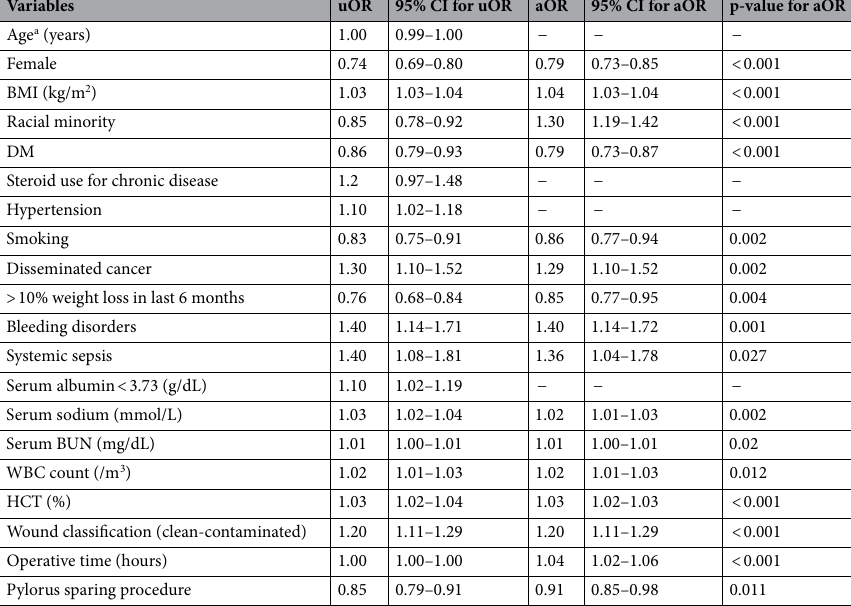
Table 4. Bivariate regression and multivariate regression analysis results for the risk factors of organ-space SSIs. Variables dropped from the model due to insignificance at the multivariate level: preoperative serum albumin, steroid use for chronic condition, age and hypertension. SSI surgical site infection, uOR unadjusted odds ratio, aOR adjusted odds ratio, CI confidence interval, BMI body mass index, DM diabetes mellitus, BUN blood urea nitrogen, HCT hematocrit, WBC white blood cells. a With patients over 89 coded as 90+.